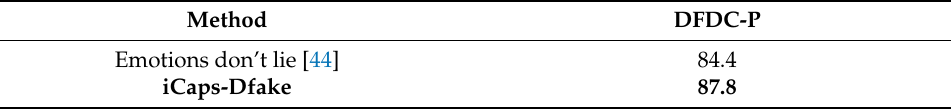
Table 5. Video-level AUC scores (%) on DFDC-P dataset.